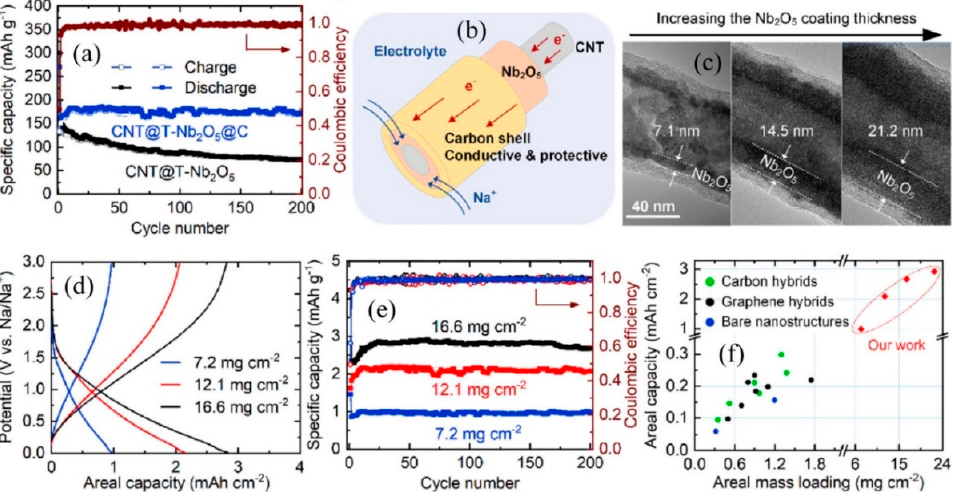
Figure 7. ( a ) Cycling performance of the CNT@T-Nb 2 O 5 @C and CNT@T-Nb 2 O 5 electrode at a current density of 100 mA g − 1 . ( b ) Schematic showing the electrochemical process within the sponge electrode. ( c ) TEM images of the CNT@T-Nb 2 O 5 @C sponge electrode with increasing thicknesses. ( d ) The discharge/charge voltage profiles at 50th cycle of the sponge electrodes with different areal mass loadings. ( e ) Cycling performance of the sponge electrodes with different areal mass loadings. ( f ) for sodium storage. Reproduced with permission from Ref. [81] Copyright 2020 Elsevier.